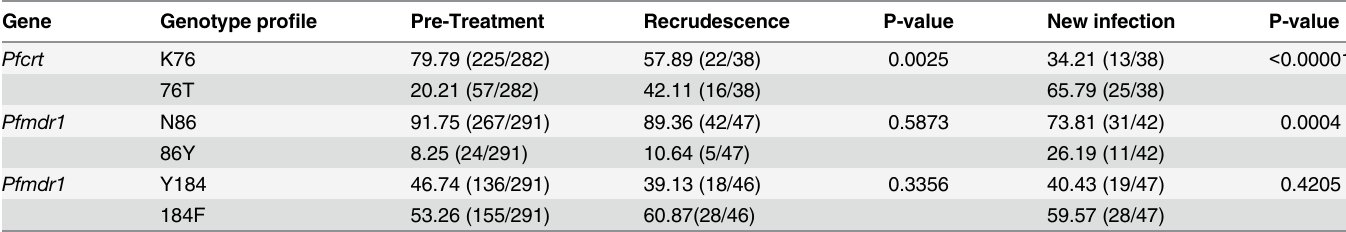
Table 2. Prevalence of Pfcrt and Pfmdr1 alleles before and after treatment with ASAQ % (n/N). Gene Genotype pro fi